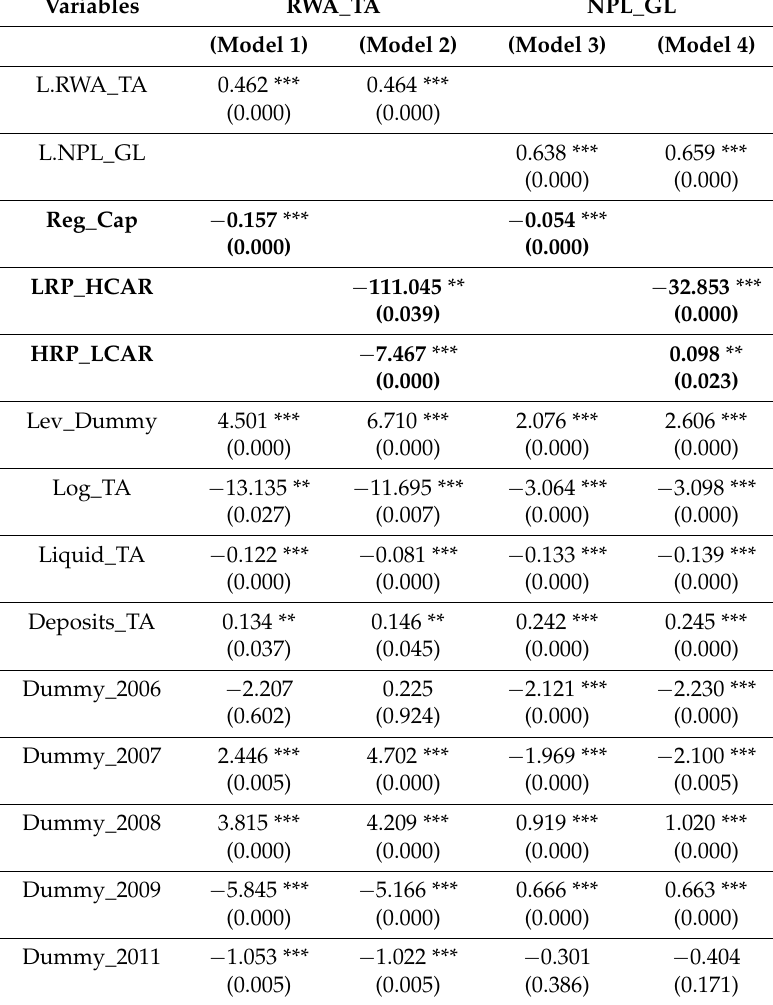
Table 5. Robustness tests: inclusion of time